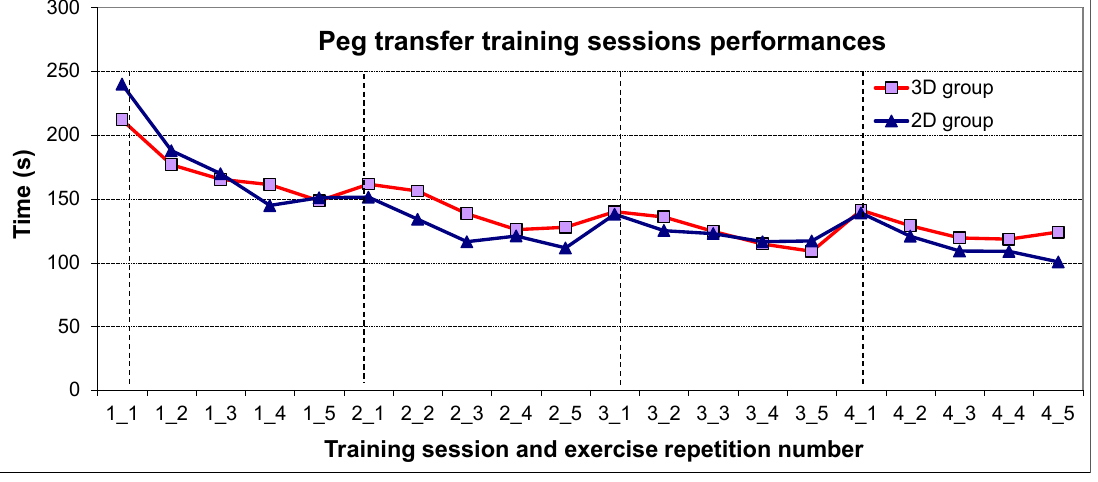
Figure 1. Peg transfer task score development over the four training sessions. The mean time for task completion in seconds is shown for each repetition of the peg transfer task at each training session. The red line represents the values for the participants of the 3D group and the blue one, those for the participants of the 2D group. The vertical lines mark the first repetition at each training session. On the x -axis, the training session and the respective repetition number are noted (for example, “1_1” means training session 1, repetition number 1).